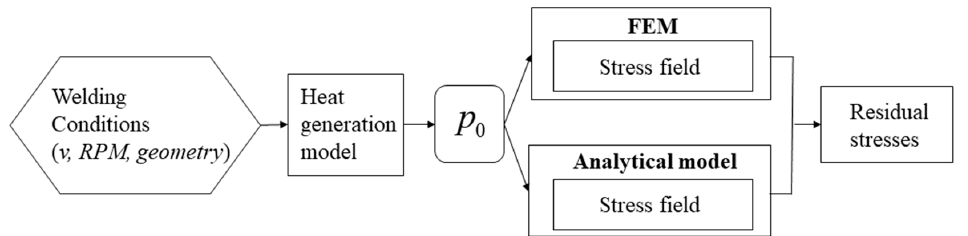
Figure 4. Schematic illustration of the HYB process applied to dissimilar metals with its main parts being involved in the joining process.